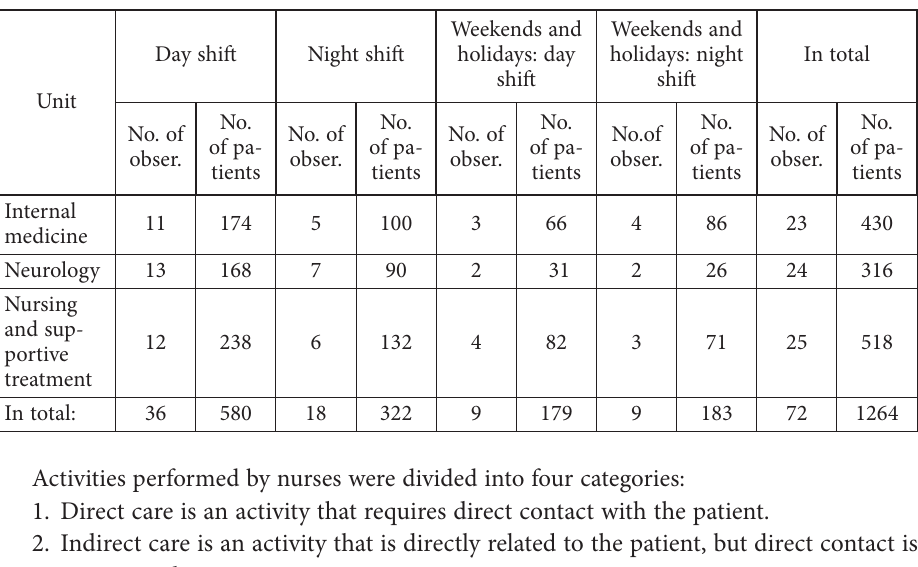
Table 1. Statistics of